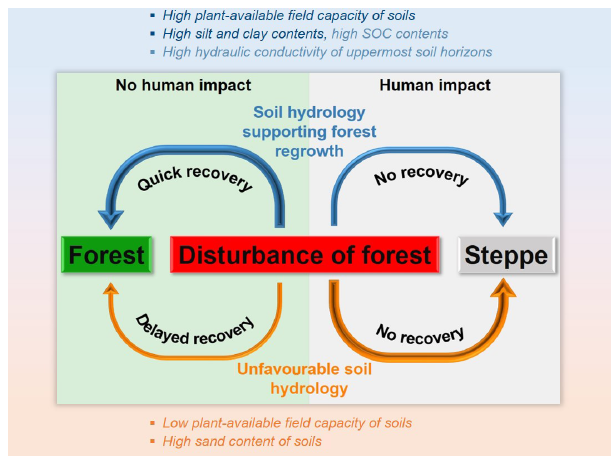
Figure 9. Possible development pathways of disturbed forests in the Mongolian forest steppe, as controlled by soil hydrology and human impact. Soil properties listed in dark blue show the significant pos- itive effect, light blue show the non-significant positive effect, and orange show the significant negative